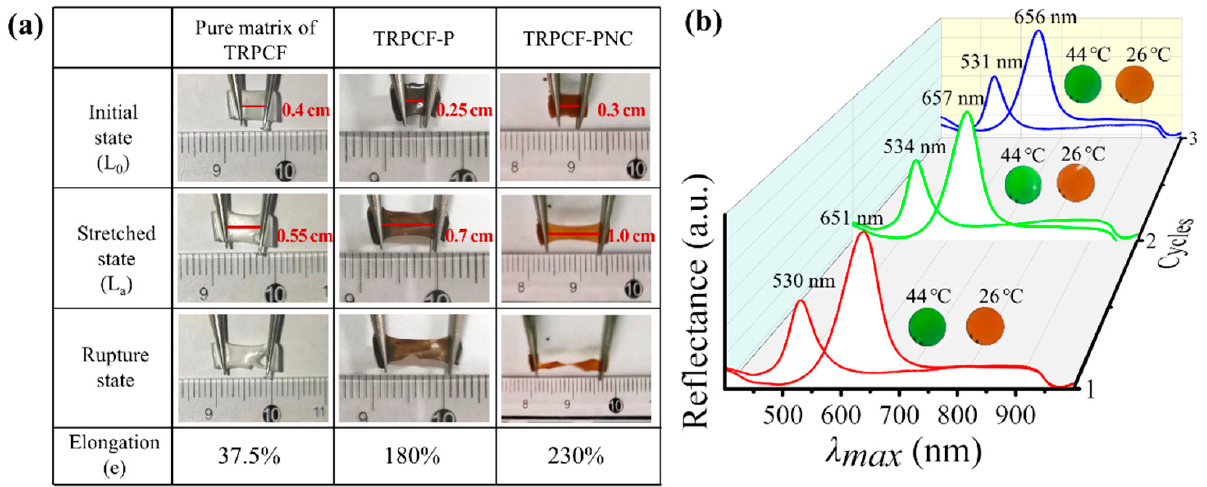
Figure 4. ( a ) The mechanical properties of the pure matrix of TRPCF, TRPCF-P, and TRPCF-PNC with a thickness of 1 cm were tested by using tweezers to stretch. ( b ) The cycling stability of TRPCF was obtained by monitoring the reflection spectrum and structural color variation through repeatedly switching the sample from 26 °C to 44 °C every two months.